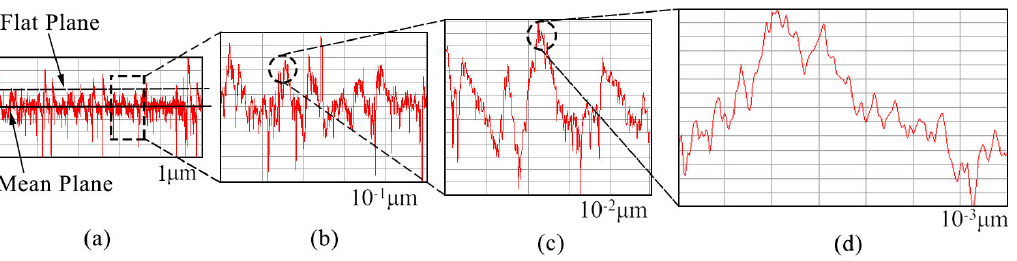
Figure 3. Schematic diagram of contact between nanoscale fractal surface and rigid rough plane: ( a ) Rigid contact surface; ( b ) Schematic diagram of rigid contact surface after being magnified by 10 times; ( c ) Schematic diagram of rigid contact surface after being magnified by 100 times; ( d ) Schematic diagram of rigid contact surface after being magnified by 1000 times.